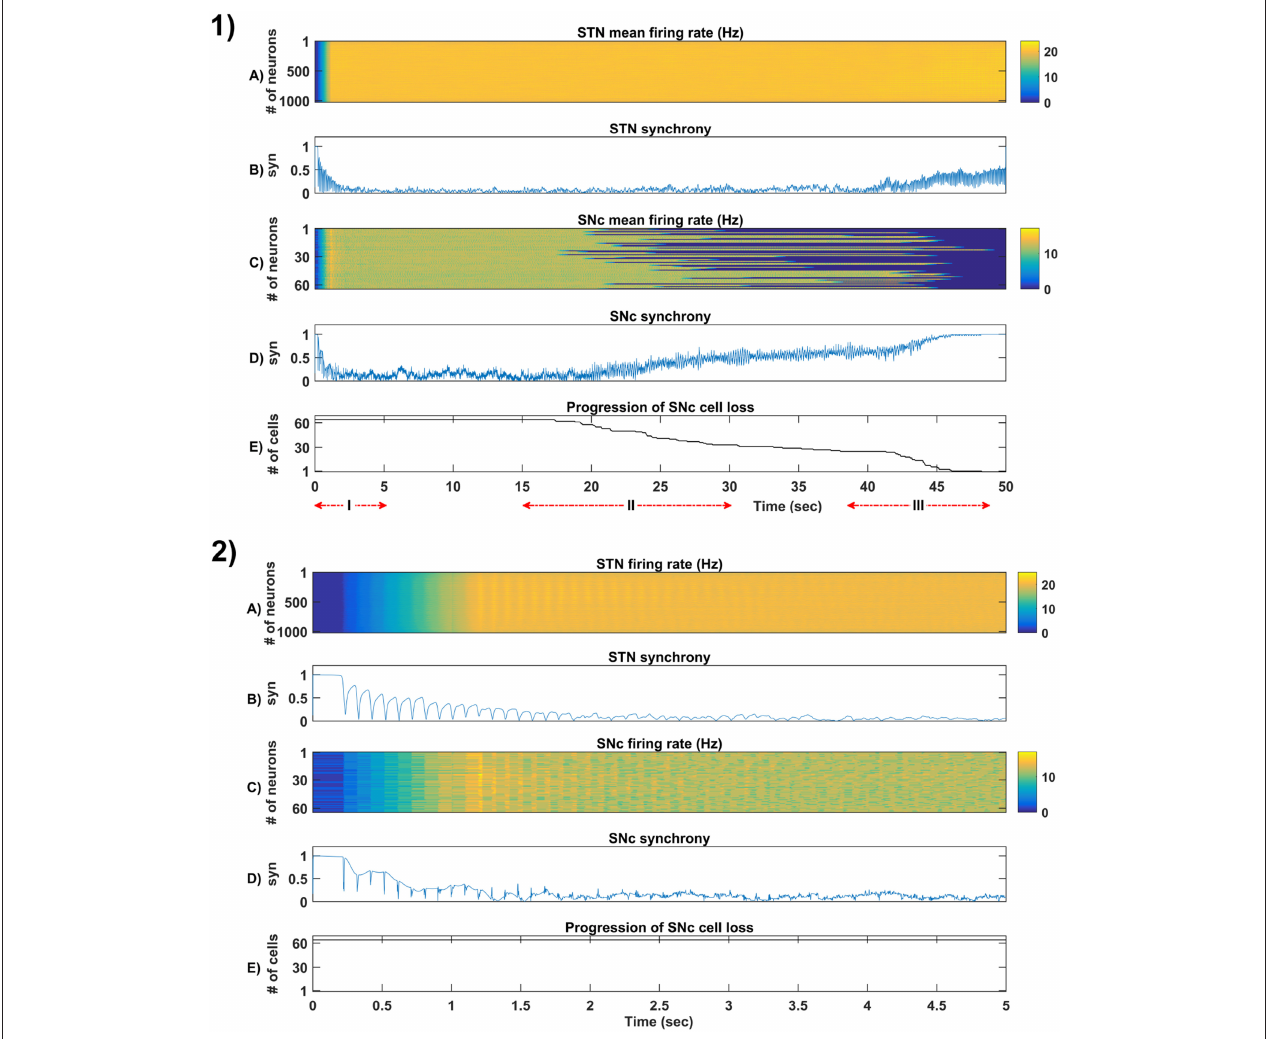
FIGURE 5 | Simulation plots of whole and step-wise mechanism (I) of the proposed excitotoxicity model. (1) Whole 50 sec simulation plots of the proposed excitotoxicity model. (2) Part-I of (1) Simulation plots of STN-SNc loop dynamics - Mean firing rate (1 s) of STN (A) & SNc (C) , Synchrony (syn) of STN (B) & SNc (D) , Progression of SNc cell loss (E) . STN, SubThalamic Nucleus; SNc, Substantia Nigra pars ompacta; GPe, Globus Pallidus